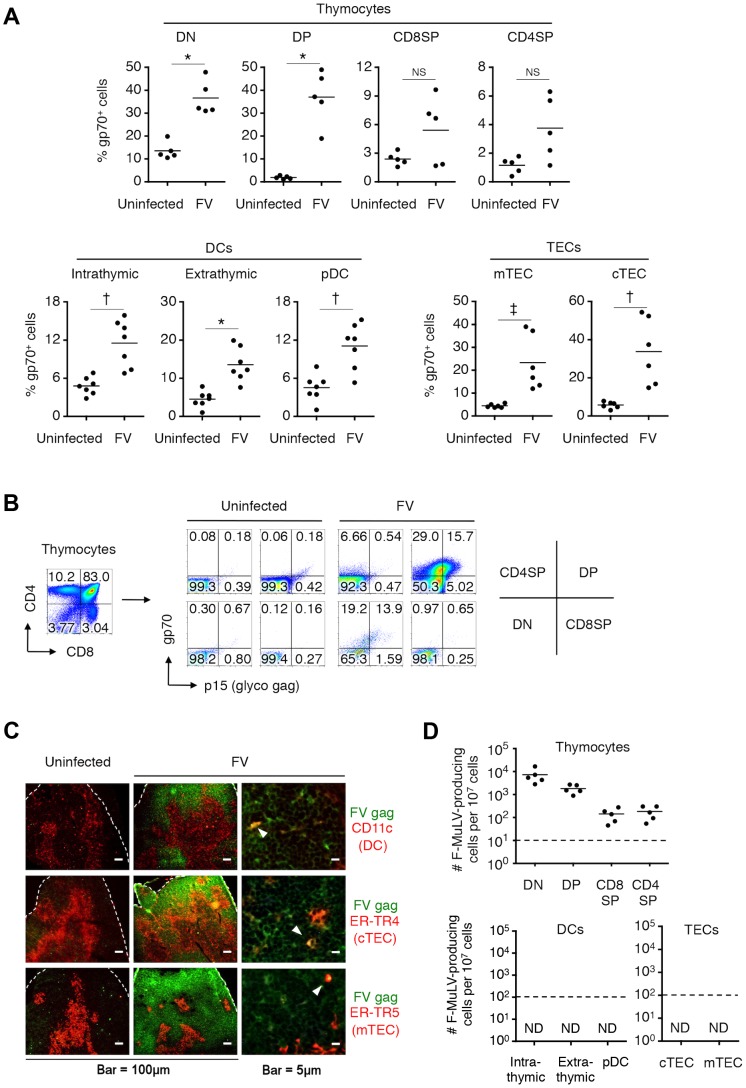
Identification of FV-infected cells in the thymus.Mice were infected with 1,000 SFFU of FV. (A) At day 14 post infection, cells in the thymus were isolated and stained with the indicated Abs. Shown are frequencies of F-MuLV gp70+ cells among indicated populations as described in Figure 2. Differences in means between uninfected and FV-infected groups were analyzed by two-way ANOVA with Bonferroni's corrections for multiple comparisons: *, p<0.0001; †, p<0.001; ‡, p<0.05. (B) Shown are representative staining patterns for cell surface gp70 and p15gag of each thymocyte population. (C) Representative frozen sections of the thymus from FV-infected mice (14 days post infection) were stained for CD11c and F-MuLV gag p30 (top), cTEC-specific ER-TR4 and F-MuLV gag p30 (middle), or mTEC-specific ER-TR5 and F-MuLV gag p30 (bottom). Arrowheads indicate cells double positive for the indicated cell surface marker and the viral antigen. A larger view field of the sections shown here can be seen in Figure S3. (D) Mice were infected with 1,000 SFFU of FV. At day 14 after infection, cells in the thymus were isolated, stained with the indicated Abs, and FACS sorted into the indicated populations as described in Figure 2. Cells were cocultured with M. dunni cells to enumerate F-MuLV infectious centers. Each symbol represents cells from an individual mouse. Dashed lines indicate the detectable limits (e.g. maximum available numbers of DCs and TECs used in this experiment were 1×105). Data are representative of two independent experiments with essentially equivalent results.